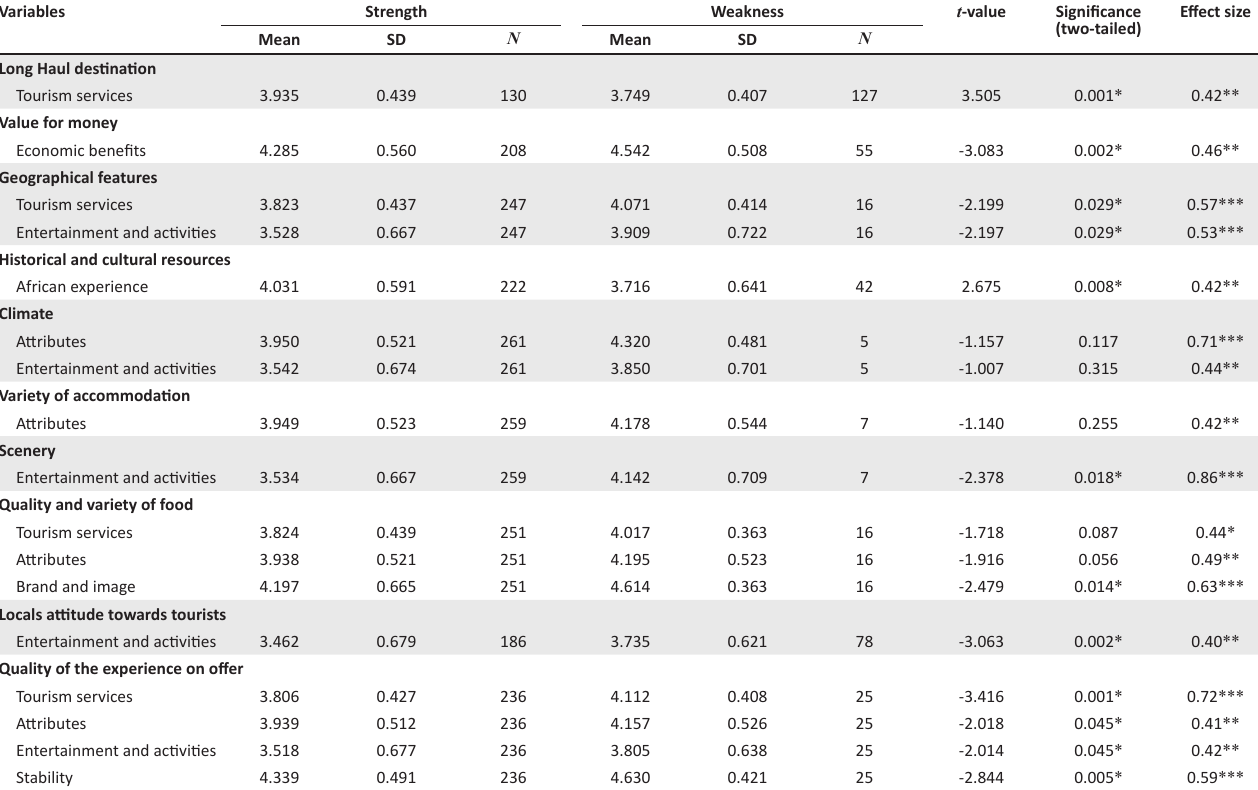
TABLE 2: Results of the t -test for the strengths and weaknesses in relation to the competitiveness factors.